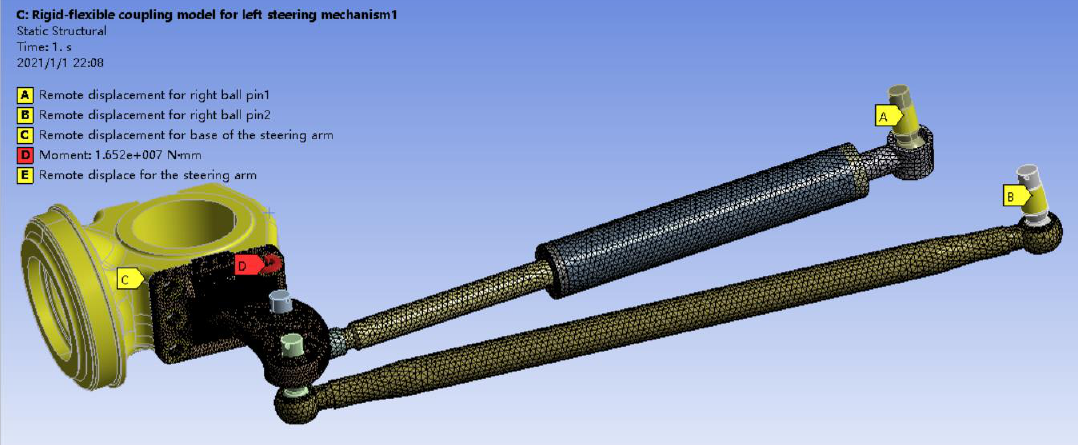
Figure 8. Rigid – flexible coupling model of the left steering mechanism. Figure 8. Rigid–flexible coupling model of the left steering